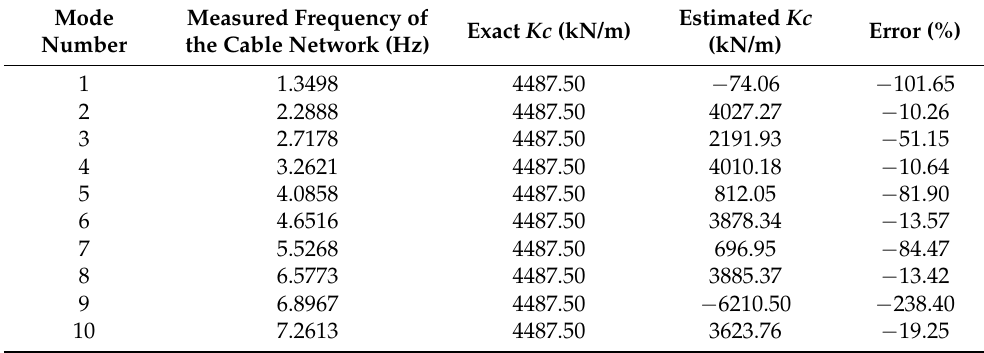
Table 8. Estimated axial stiffness of the